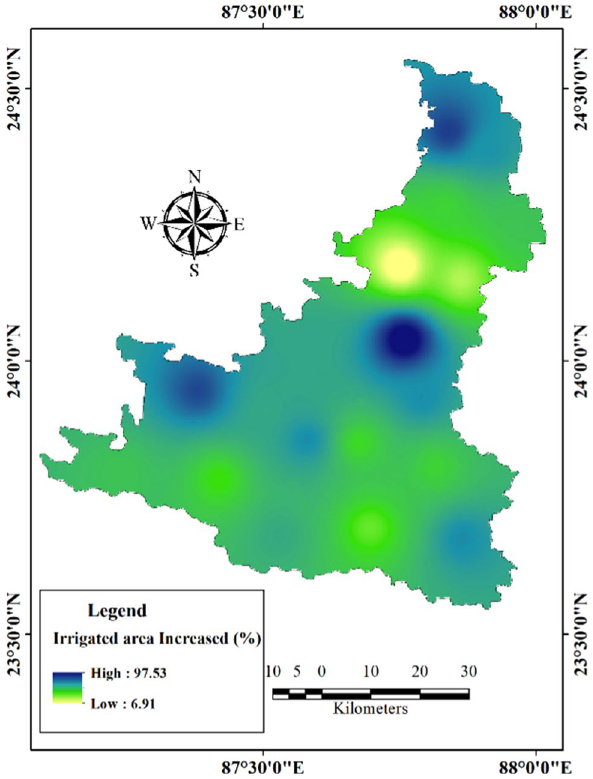
Fig. 19 Increase in irrigated area between 1996 and 2018